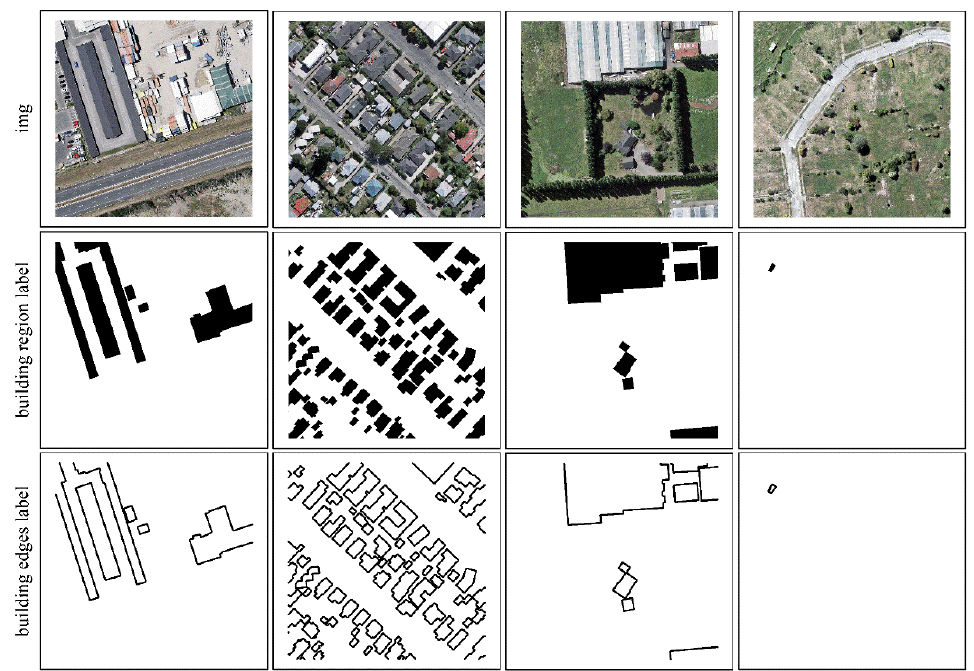
Figure 4. The sample of WHU building dataset.